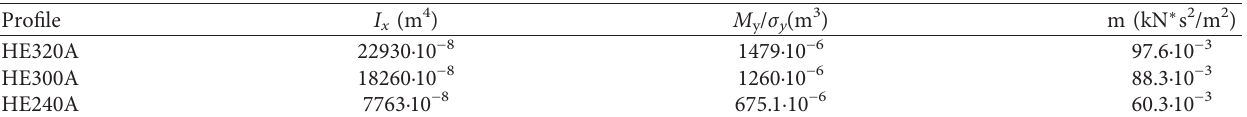
Table 1: Characteristics of the structural